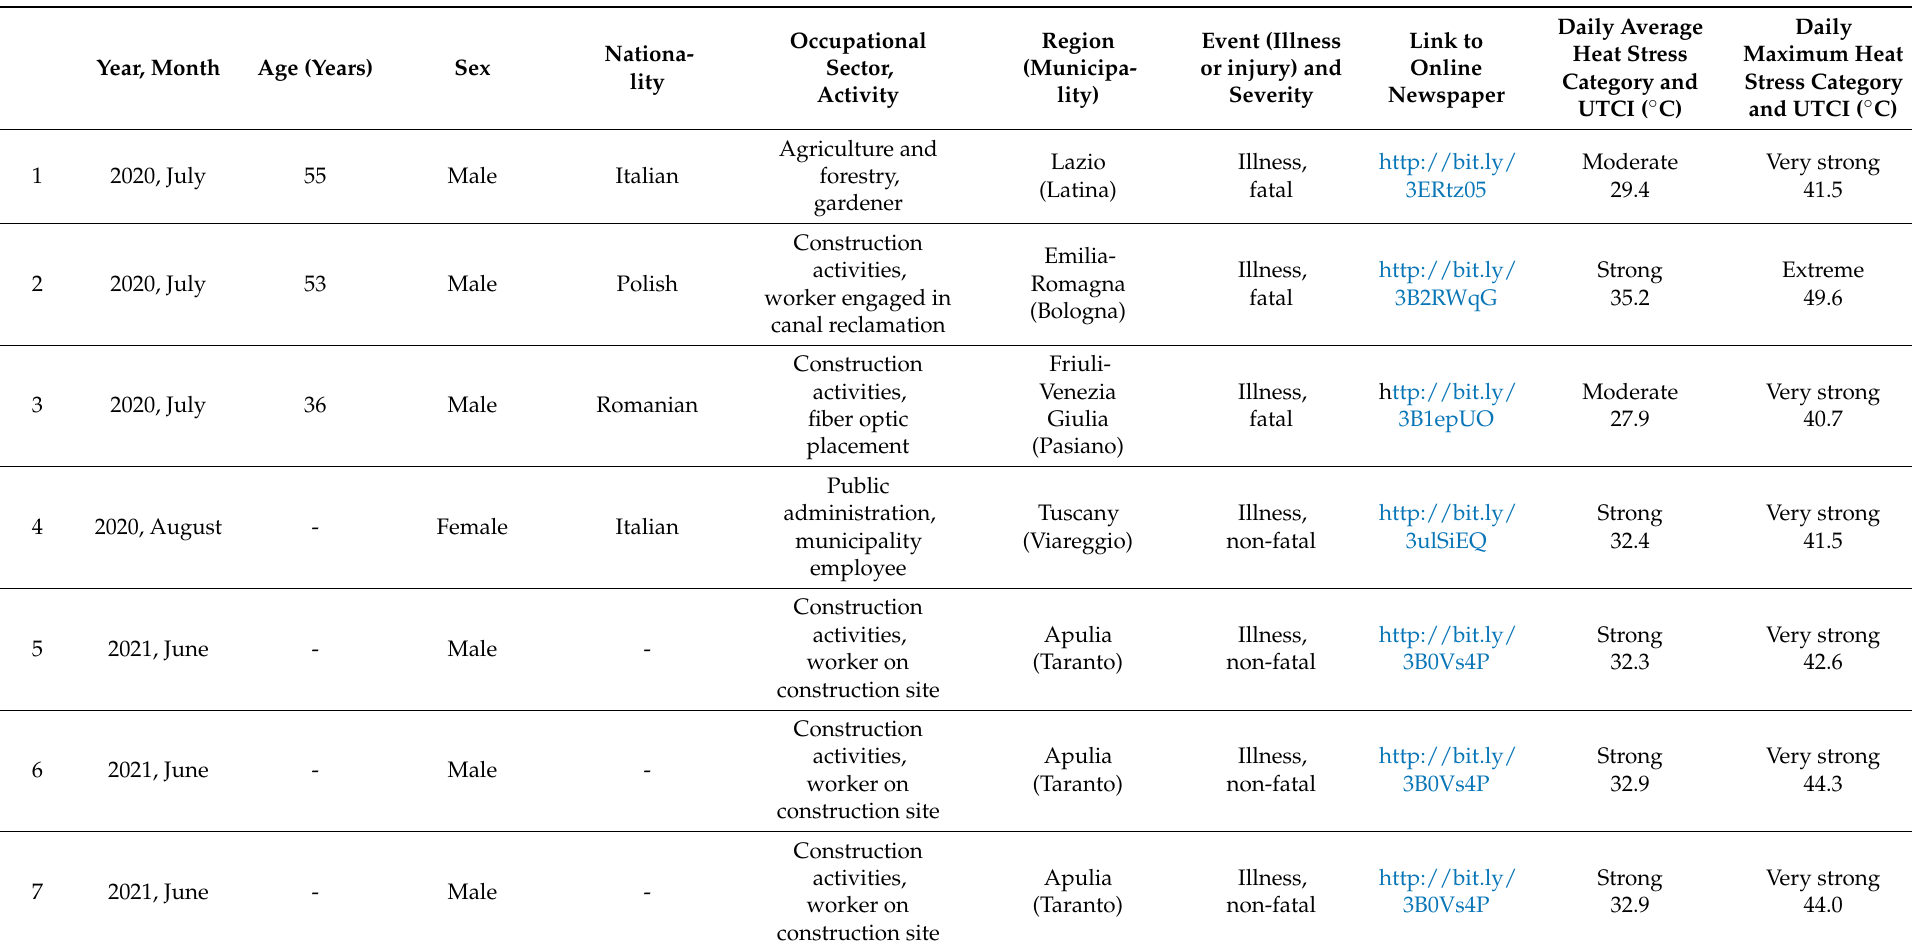
Table 1. Summary table of heat-related illnesses and injuries in the workplace reported in the Italian national press. Details of published data—years 2020–2022. (All website accessed on 7 February